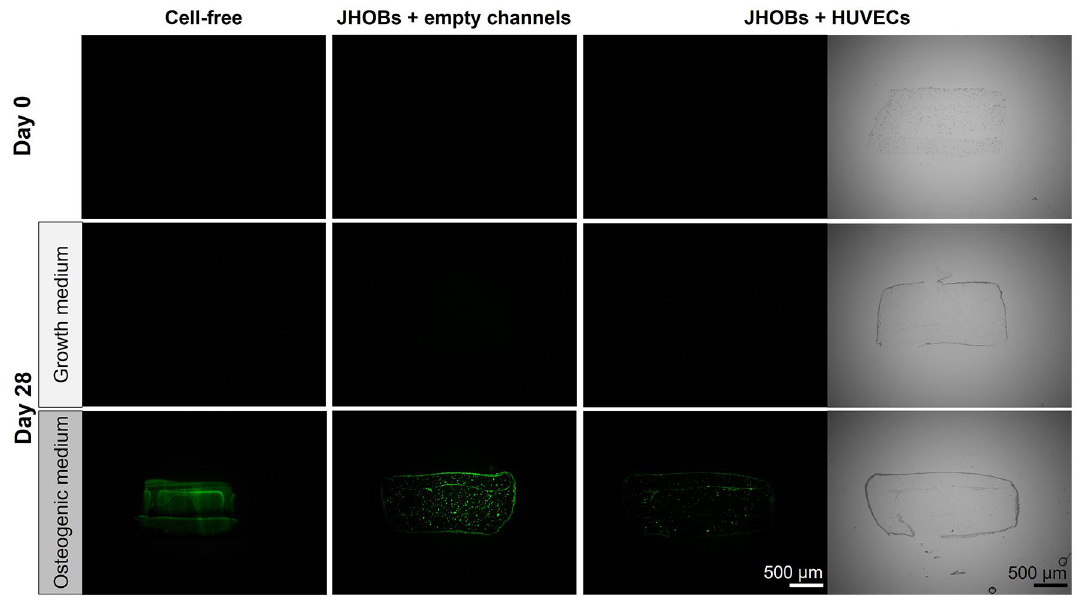
Figure 3. Mineralisation of the bioprinted human jawbone models. Histological staining of the prints on day 0 and day 28, using OsteoImage Mineralization Assay. For localisation of the sections, representative brightfield images are shown for the JHOBs + HUVECs